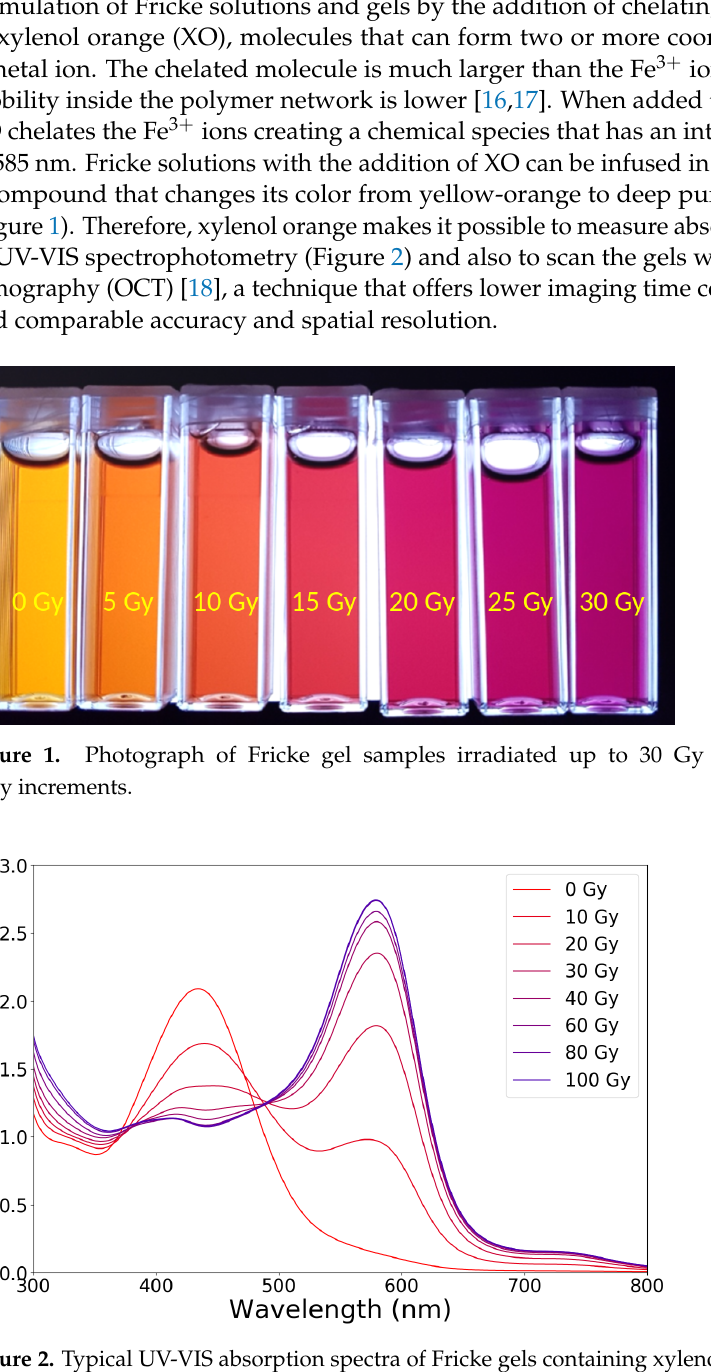
Figure 2. Typical UV-VIS absorption spectra of Fricke gels containing xylenol orange and irradiated to absorbed doses up to 100